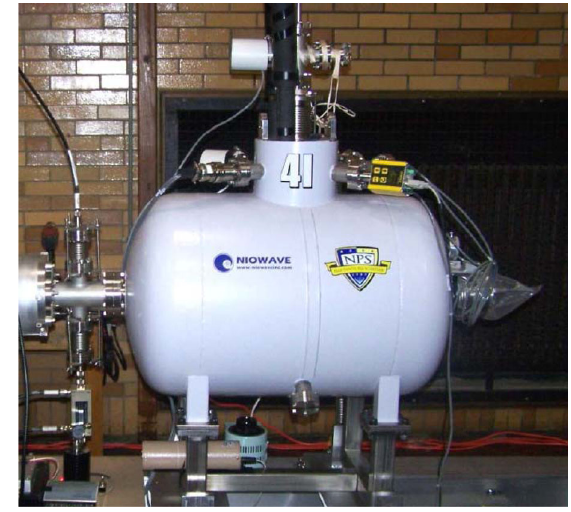
FIG. 1. The 500 MHz quarter-wave SRF gun. This photograph was taken before insertion of the cathode stalk and application of lead sheet radiation shielding. Note the power coupler connec- tions to the left of the cavity.